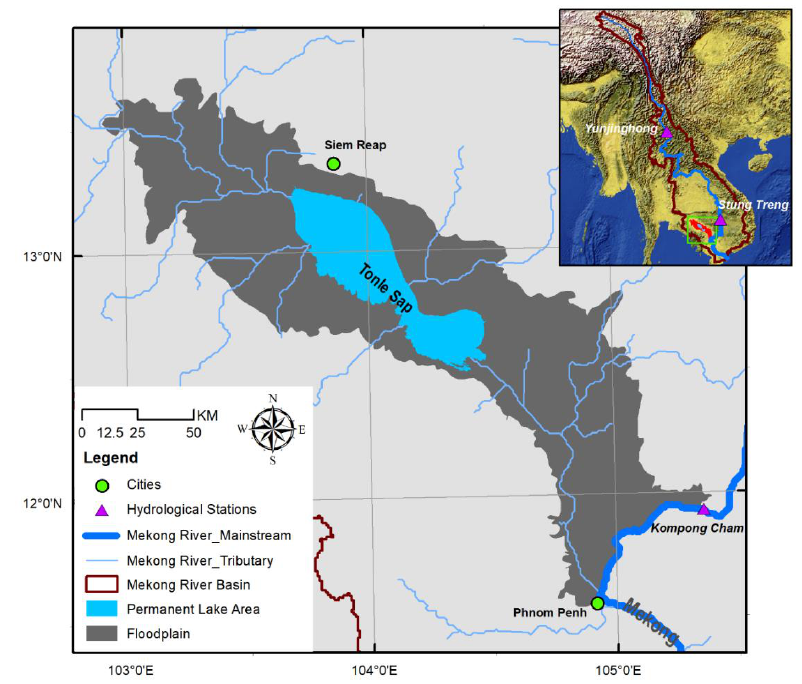
Figure 1. Location and Map of Tonle Sap Lake.